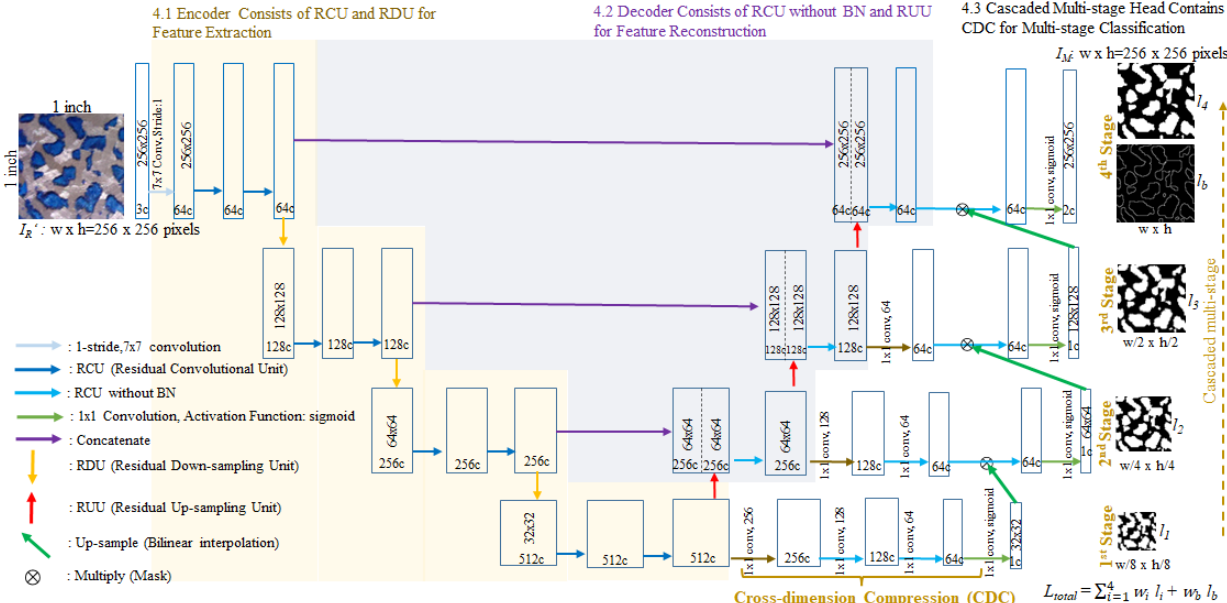
Figure 6. The architecture of cascaded U-Net segmentation consists of an encoder, decoder, and cascaded multi-stage